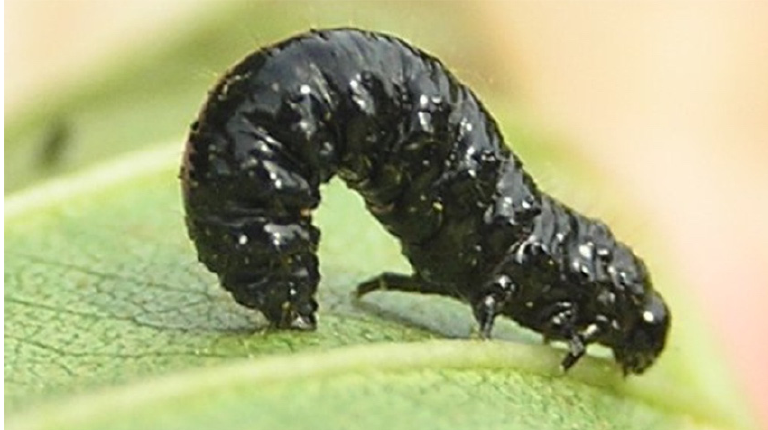
Figure 4. Agelastica alni (Linnaeus, 1758) larva. Image credit: I. Beentree.